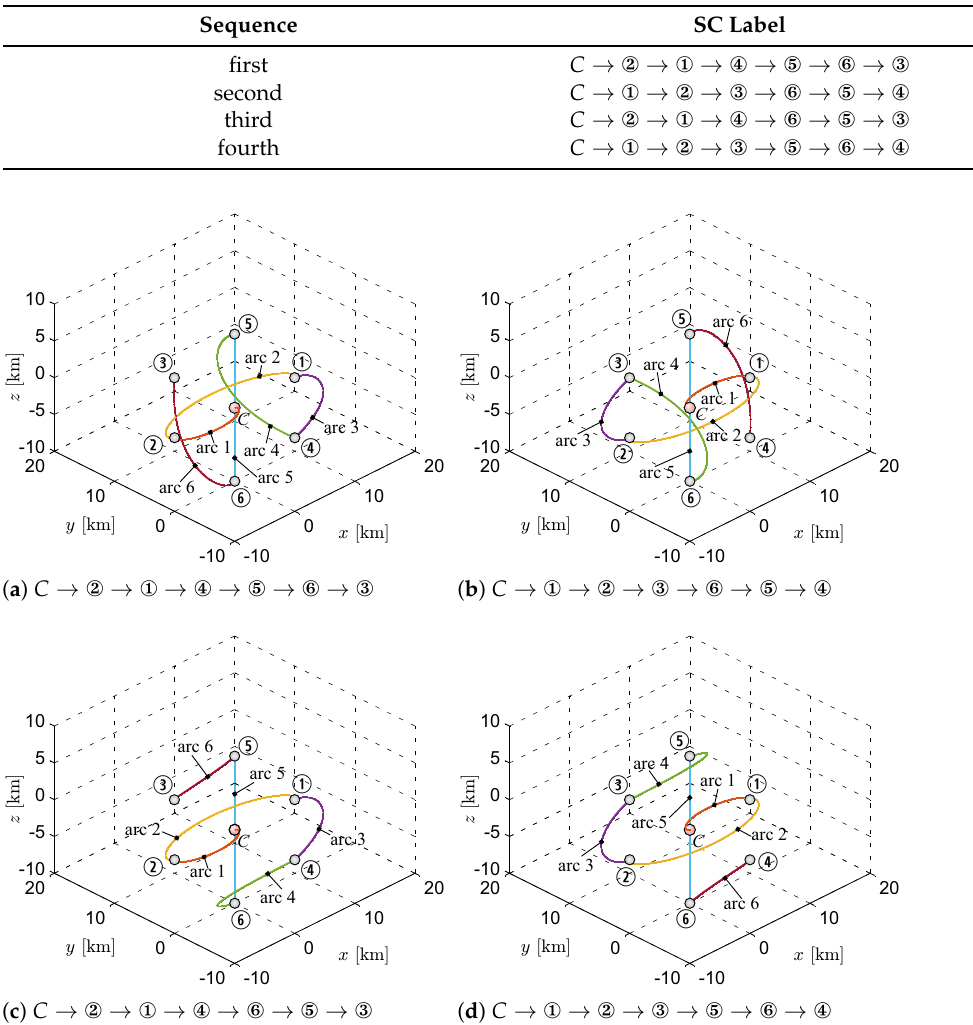
Figure 9. Optimal IS inspection trajectories in the four optimal sequences listed in Table